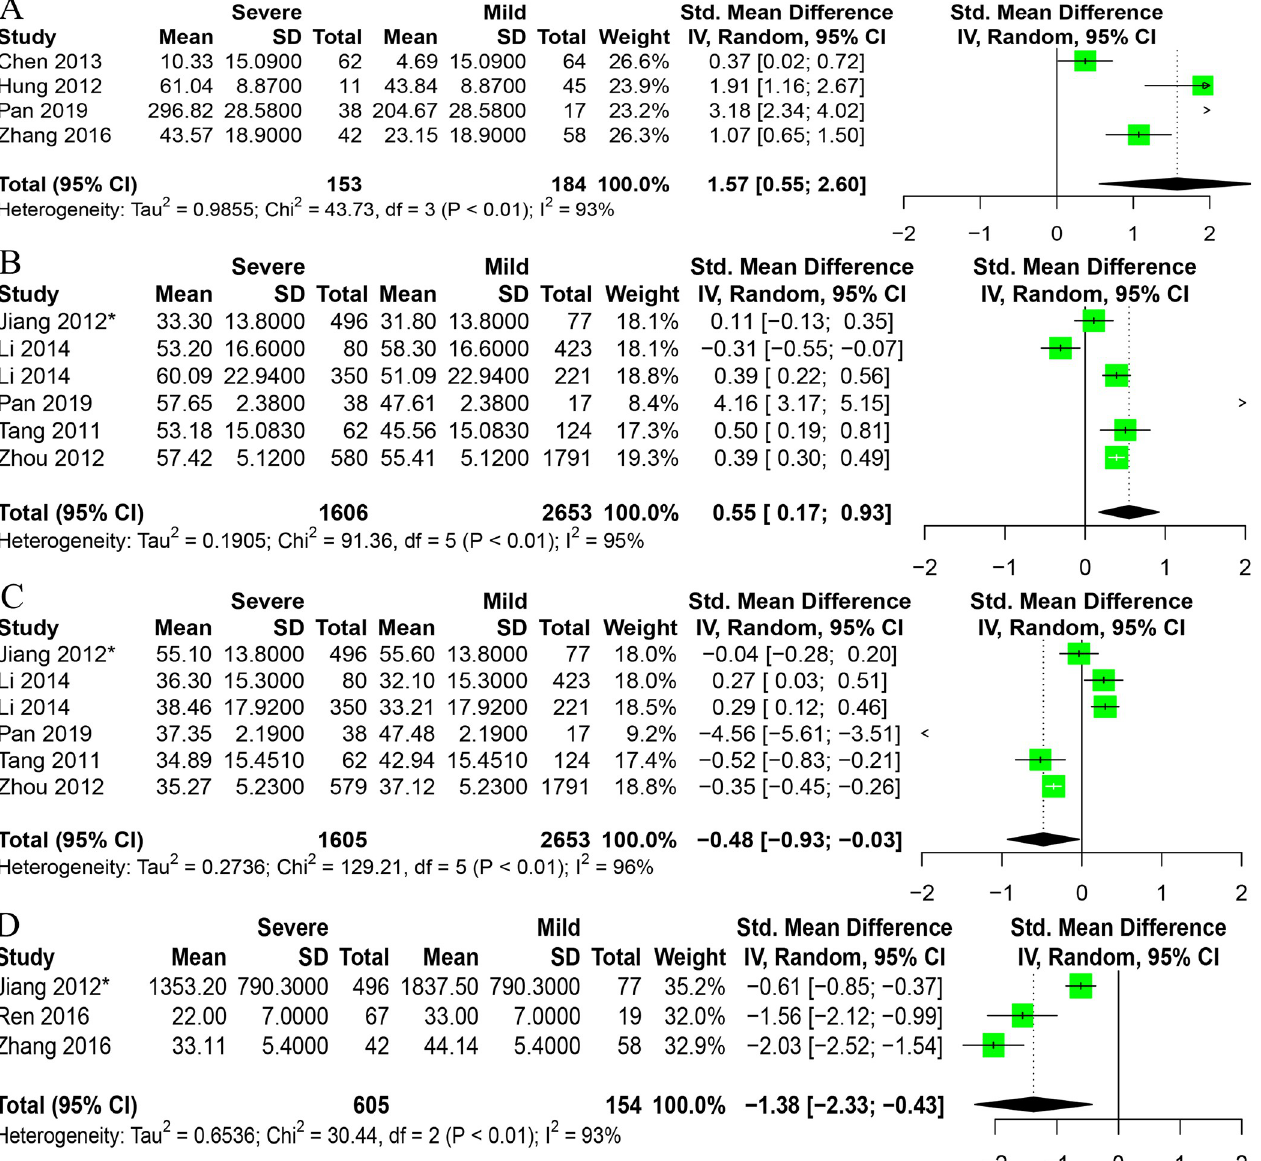
PLOS ONE | https://doi.org/10.1371/journal.pone.0267716 April 28,